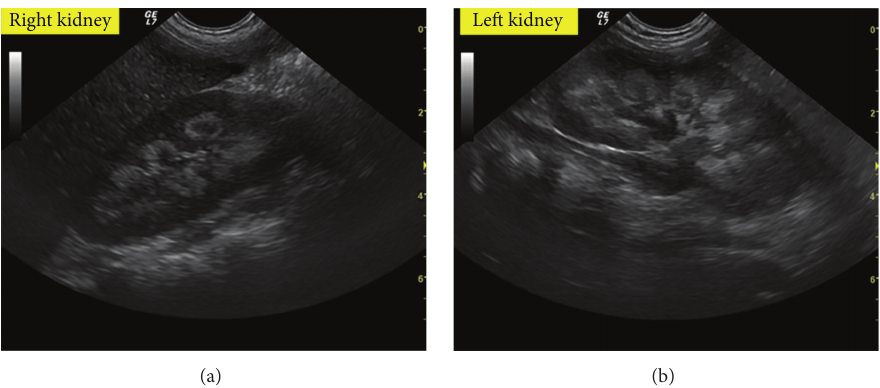
Figure 1: Examination of the right (a) and the left (b) kidneys: the kidneys are normal in size but exhibit multiple areas of increased echogenicity involving all of the medullary pyramids, without posterior acoustic shadowing; increasing beginning in the periphery of the renal